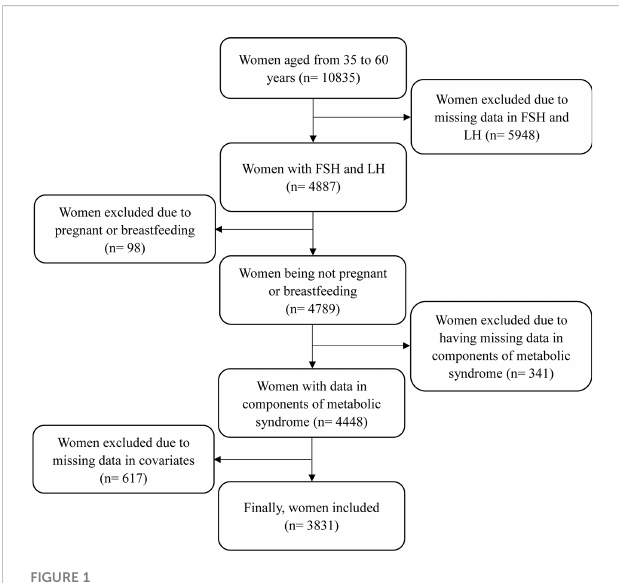
FIGURE 1 The detailed process of participants